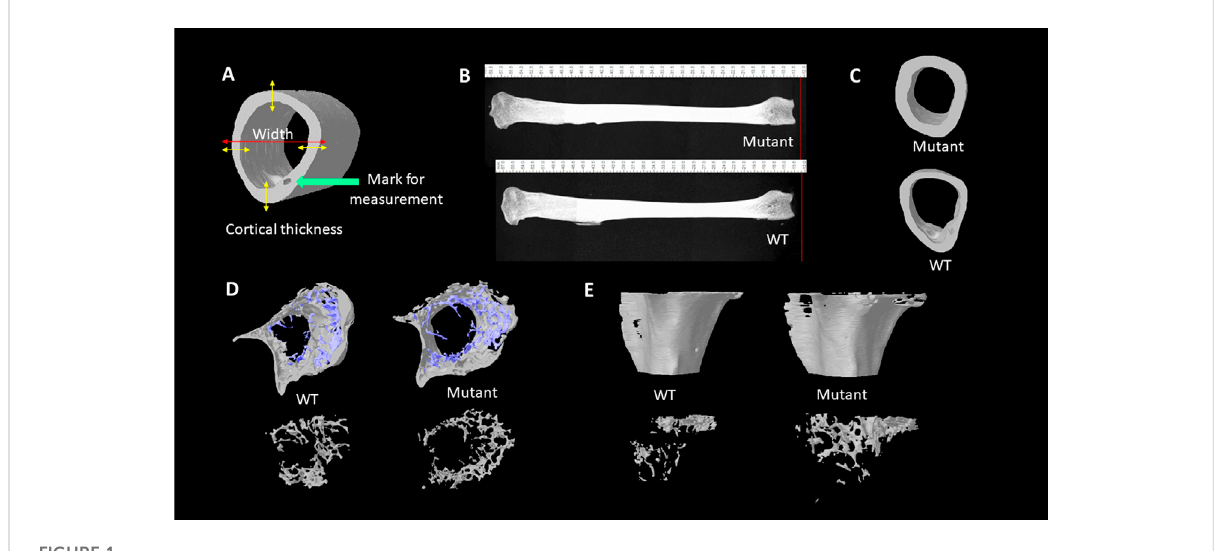
FIGURE 1 (A). Illustration of cortical thickness and wideness measurement. (B). Lateral views of 4 months old male quail tibia bones. The length of bones was measured with the CTAn ruler tool. (C). Transverse views of tibia diaphysis acquired from the micro-CT scanning. (D). Transverse views of tibia metaphysis with trabecular bones (blue) and cortical (grey) structures. Transverse views of tibia metaphysis trabecular bone structures (bottom). (E). Lateral views of the reconstructed metaphysis of tibia bones (top). Lateral views of trabecular bones at tibial metaphysis area